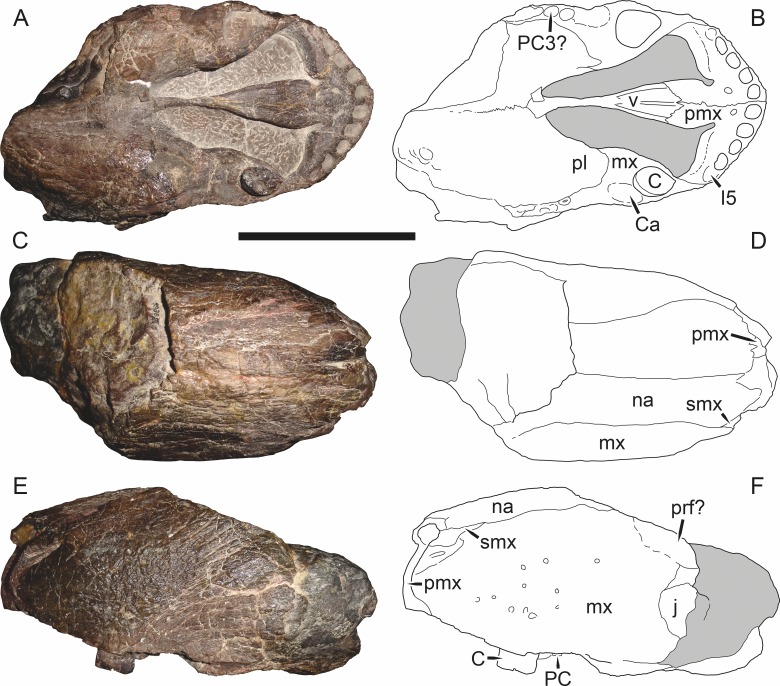
Holotype (BSPG 1936 III 1) of Sycosaurus nowaki (Broili & Schröder, 1936) in (A) ventral, (C) dorsal, and (E) left lateral view (with (B) (D) and (F) interpretive drawings).Abbreviations: C, upper canine; Ca, canine alveolus; I, upper incisor; j, jugal; mx, maxilla; na, nasal; PC, upper postcanine; pmx, premaxilla; prf, prefrontal; smx, septomaxilla; v, vomer. Gray indicates matrix. Scale bar equals 10 cm.